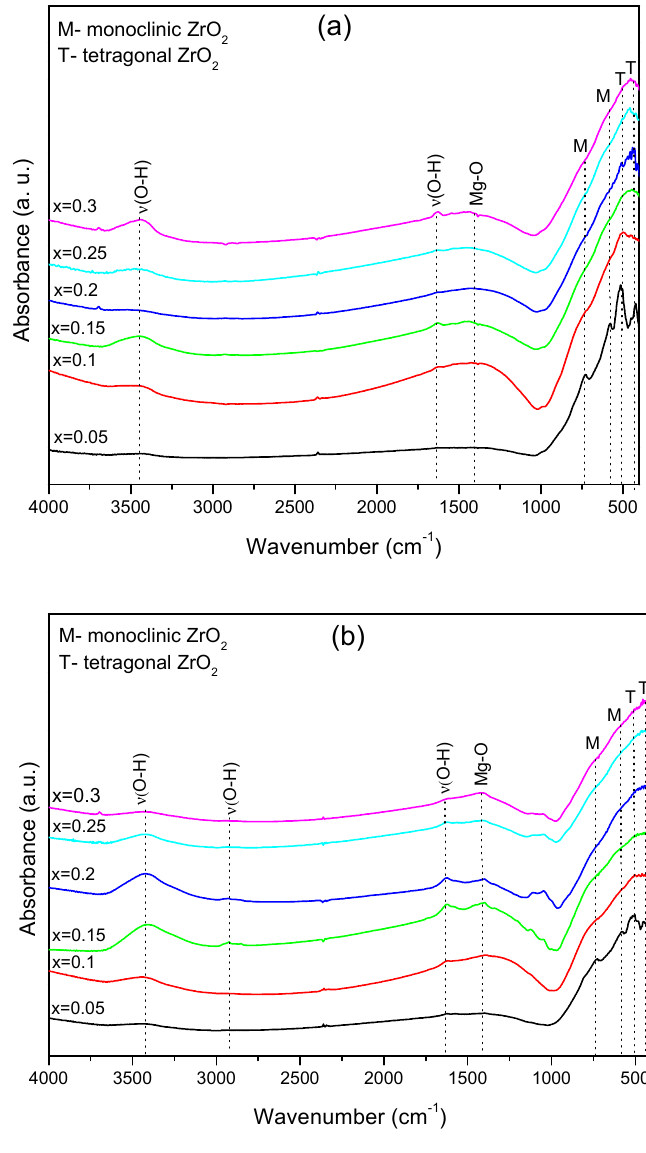
Figure 2. FTIR spectra of compositions belonging to Zr 1 − x Mg x O 2 (x = 0.05, 0.1, 0.15, 0.2, 0.25, 0.3) bioceramics ( a ) before and ( b ) after immersion in Xerostom ® , in the spectral domain 4000 − 400 cm − 1 .